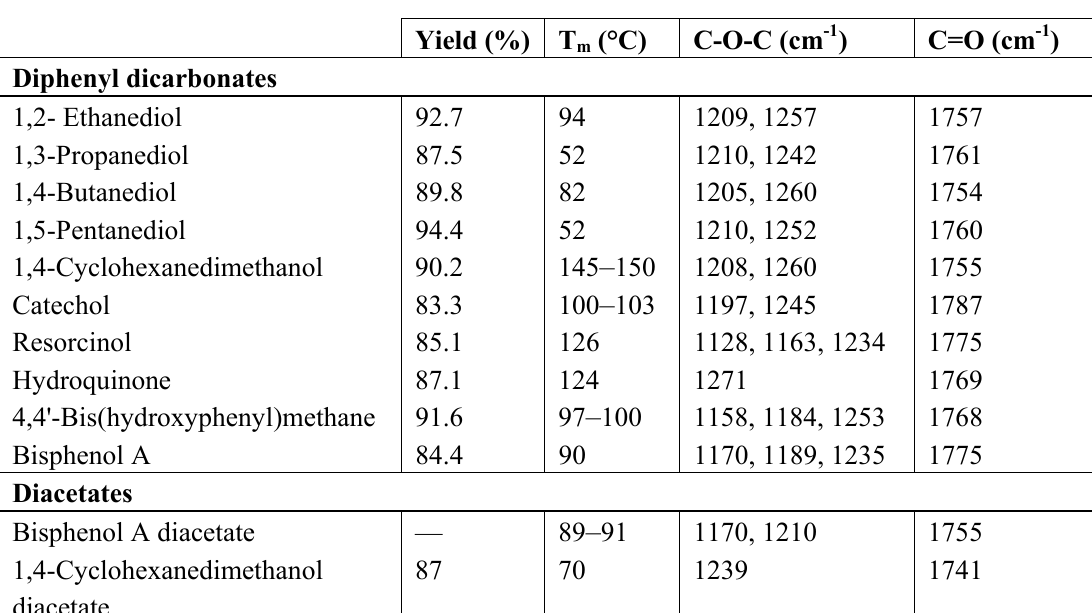
Table 1. The yield and physical properties of alkylene- and arylenediphenyl dicarbonate and diacetate